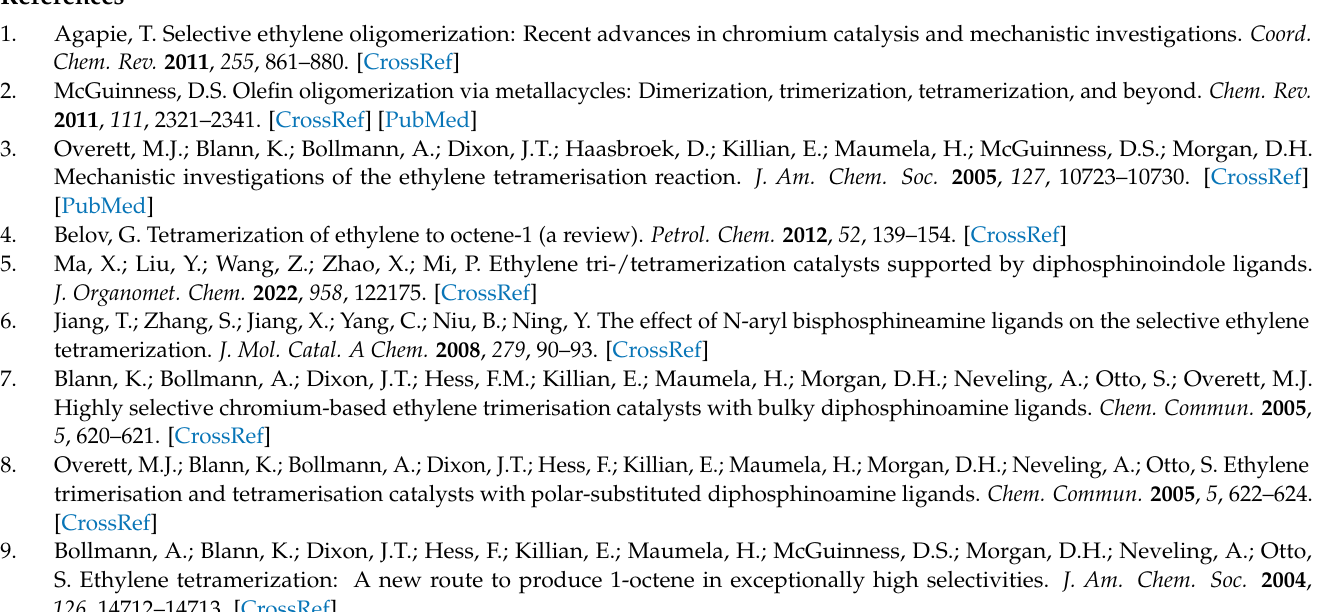
Spectrum of L1, Figure S2: 31 P NMR Spectrum of L1, Figure S3: 13 C NMR Spectrum of L1, Figure S4: 1 H NMR Spectrum of L2, Figure S5: 31 P NMR Spectrum of L2, Figure S6: 13 C NMR Spectrum of L2, Figure S7: 1 H NMR Spectrum of L3, Figure S8: 31 P NMR Spectrum of L3, Figure S9: 13 C NMR Spectrum of L3, Figure S10: 1 H NMR Spectrum of L4, Figure S11: 31 P NMR Spectrum of L4, Figure S12: 13 C NMR Spectrum of L4, Figure S13: 1 H NMR Spectrum of L5, Figure S14: 31 P NMR Spectrum of L5, Figure S15: 13 C NMR Spectrum of L5, Figure S16: 1 H NMR Spectrum of L6, Figure S17: 31P NMR Spectrum of L6, Figure S18: 13 C NMR Spectrum of